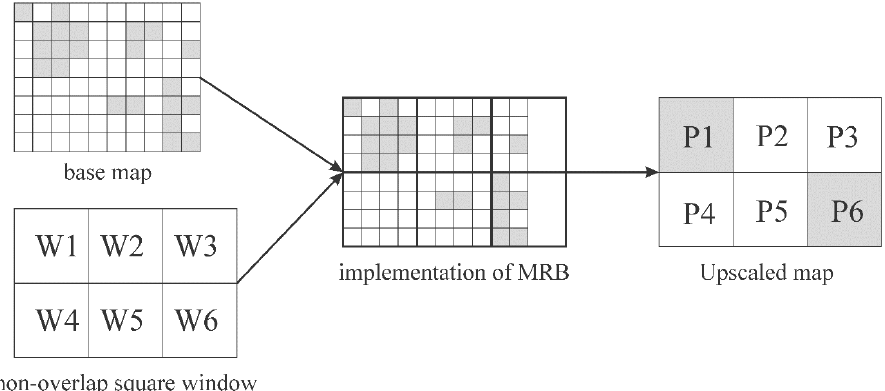
Figure 7. Boundary issues derived from the implementation of the Majority Rule Based (MRB).